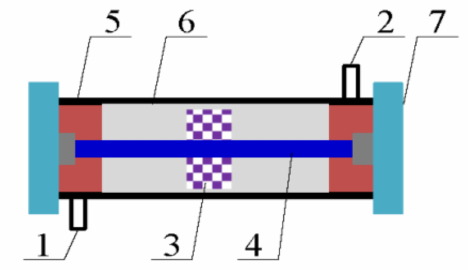
Figure 13. Schematic diagram of the plasma reactor structure. 1 Inlet, 2 Outlet, 3 Mn-Cu / ZSM5 catalyst, 4 Internal electrode, 5 Dielectric tube, 6 Ground electrode, and 7 Sealing